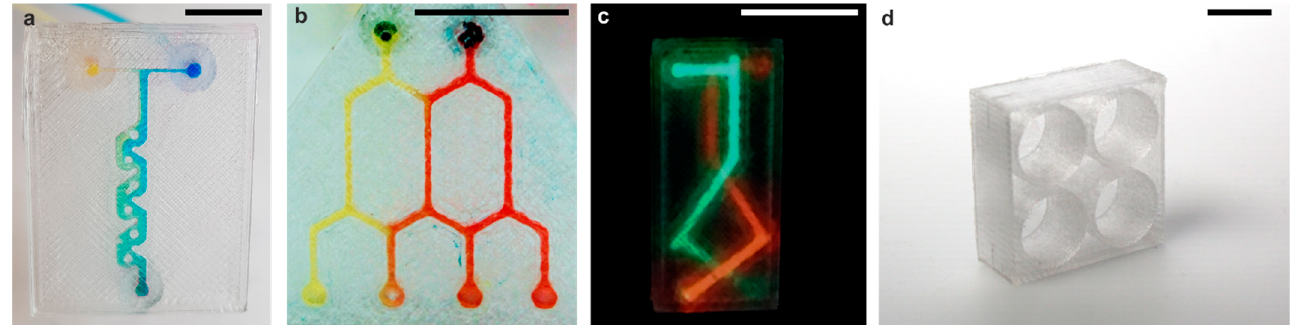
Figure 4. Applications of FDM printing of transparent PS. ( a ) A 2.5-dimensional microfluidic tesla-mixer with a square channel cross-section of 600 µm width and height. A blue and a yellow dye were mixed along the cascade. ( b ) A 2.5D mixer cascade with a square channel cross-section of 600 µm width and height. The mixing of a yellow and red dye demonstrates the creation of mixing gradients. ( c ) An FDM-printed microfluidic structure with two intertwining 3D microchannels of 600 µm width and height filled with fluorescent dyes to demonstrate the three-dimensionality. ( d ) An exemplary FDM-printed customized well-plate (scale bars 10 mm).